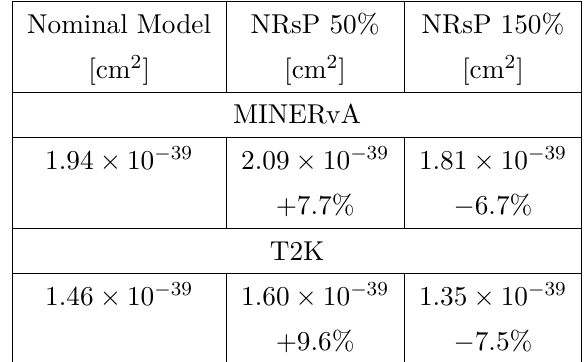
) differential dis- T